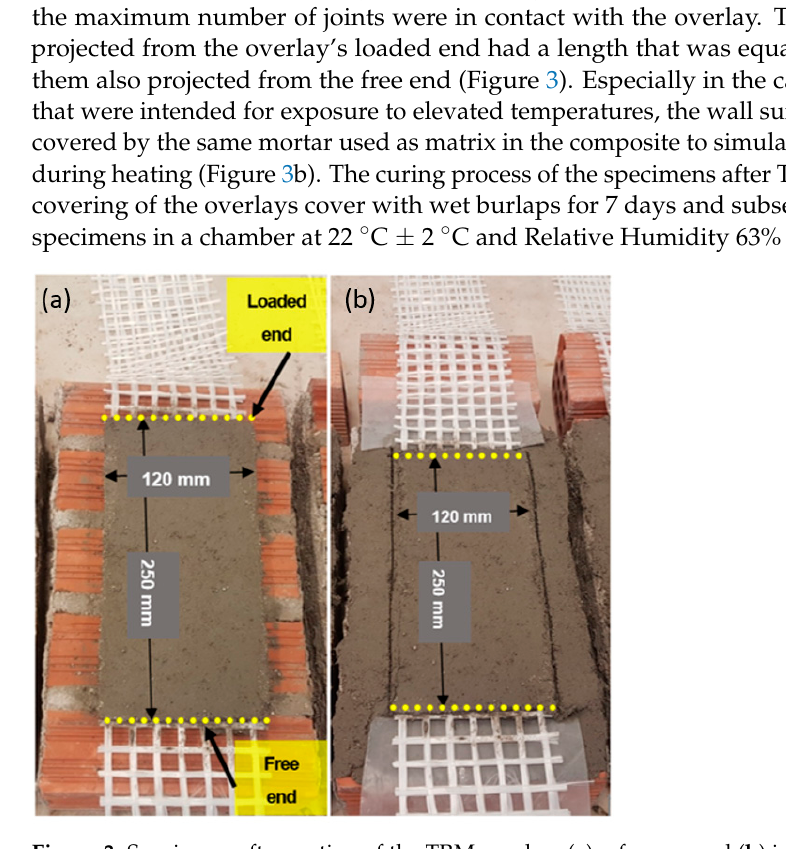
Figure 3. Specimens after casting of the TRM overlay: ( a ) reference and ( b ) intended for exposure to elevated temperature.